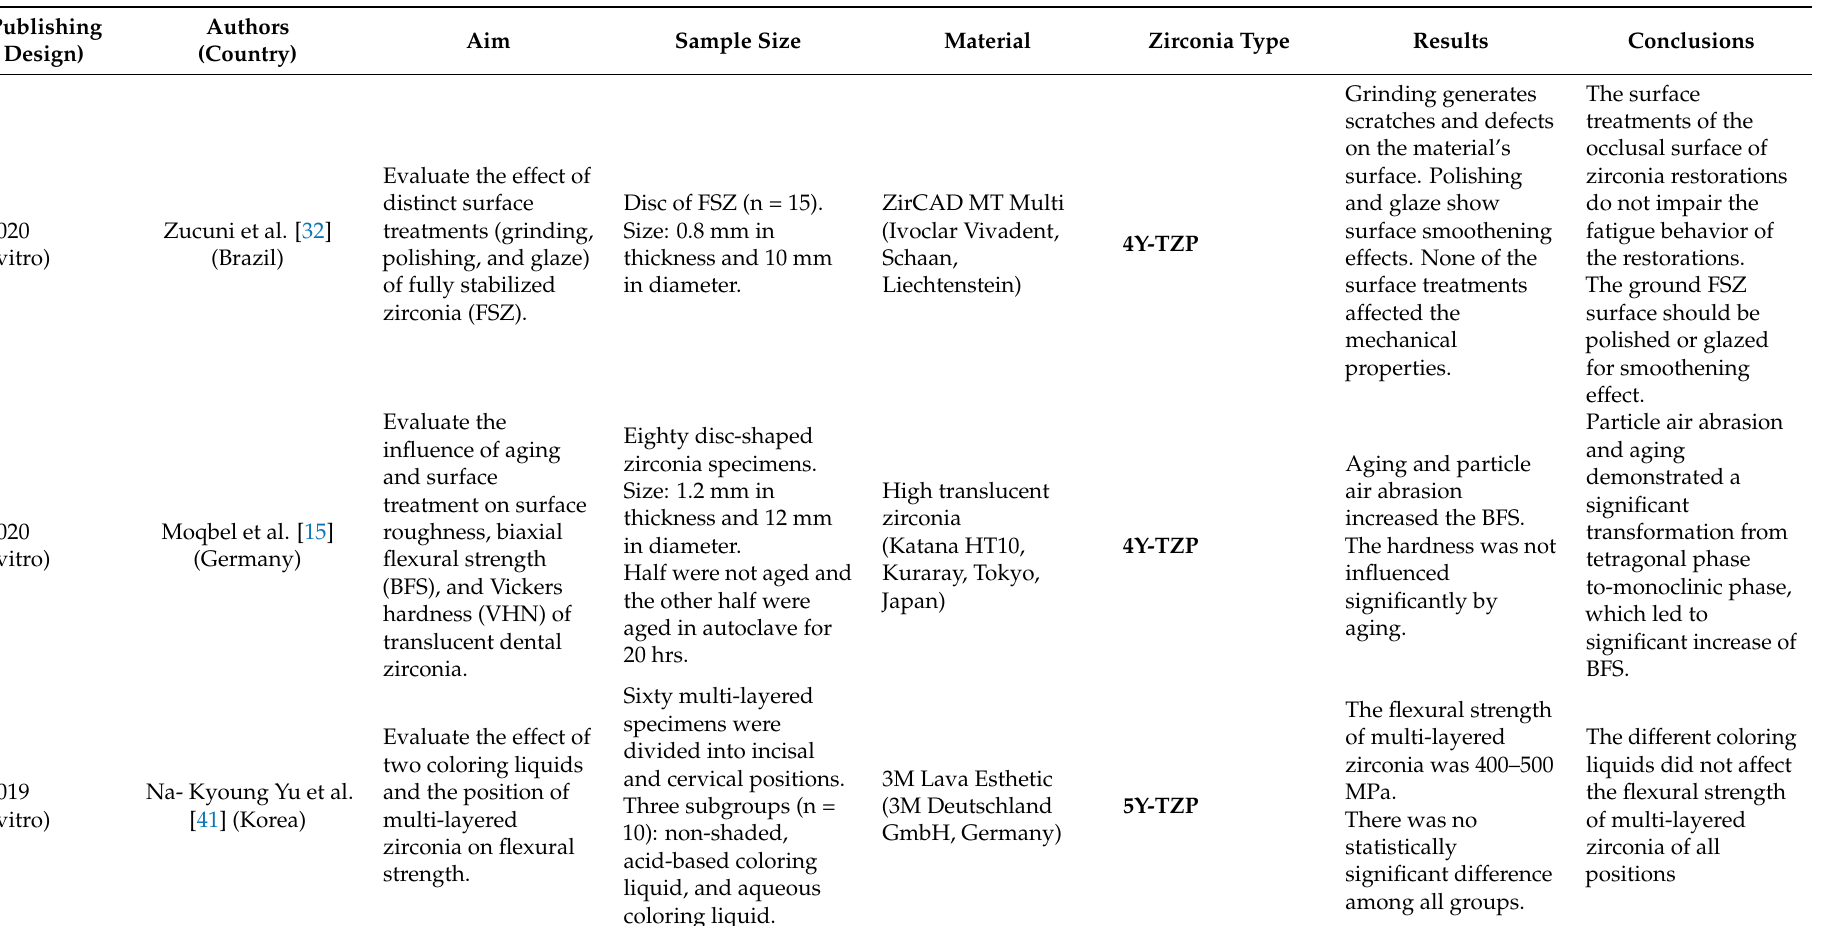
Table 1. Summary of clinical and in vitro studies